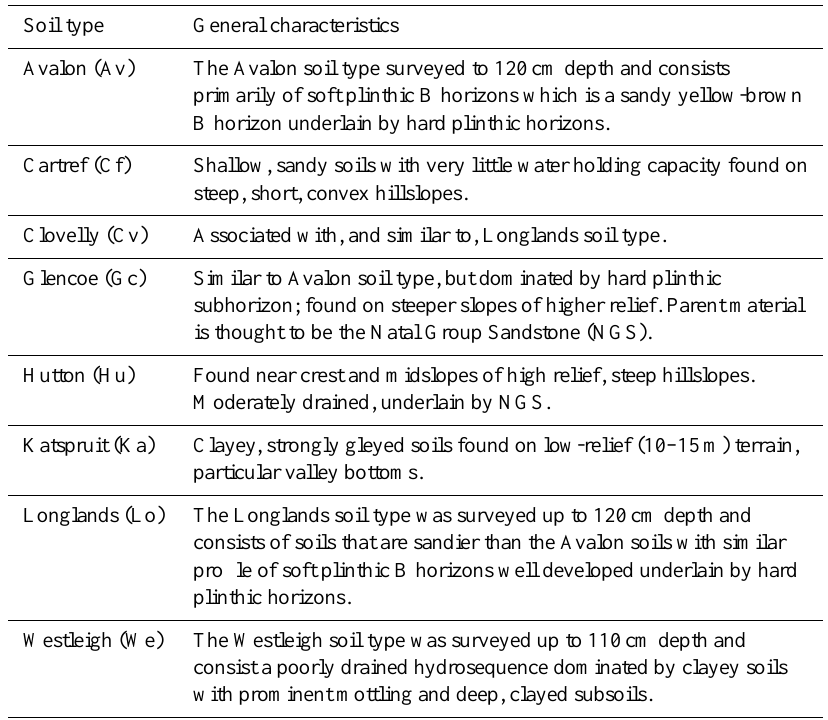
Table 6. Brief description of the primarily soil types found in the study area (after Le Roux et al., 2006). Soil